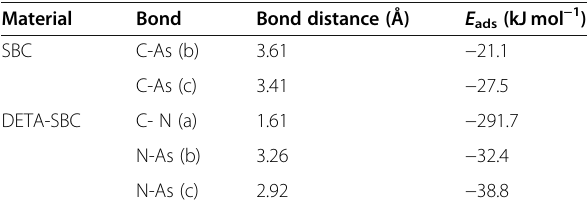
Table 2 E ads value of As (III) and DMA adsorbed onto each